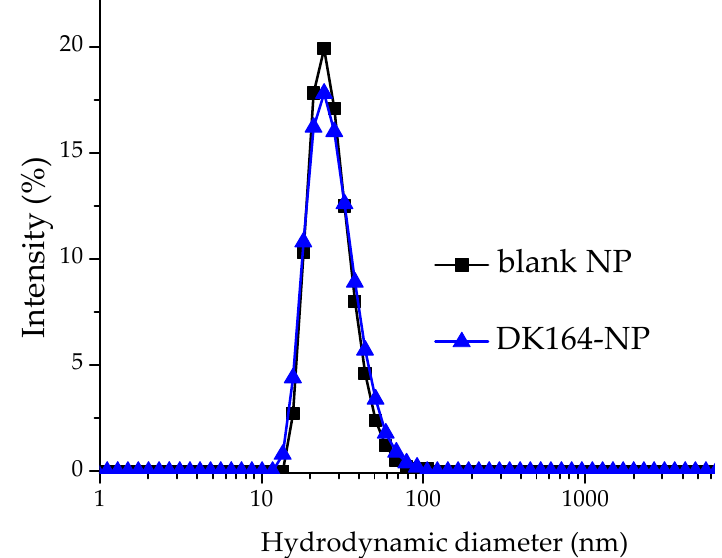
Figure 2. Hydrodynamic diameter distribution of blank and drug-loaded micelles. The calculated values of hydrodynamic diameter (D h ), dispersity index (DI) and zeta potential are listed in Table 1. The polymeric carriers possess nanoscopic dimensions and nearly neutral surface charge. Expectedly, embedding DK164 into the micellar core did not alter the main physicochemical characteristics of the